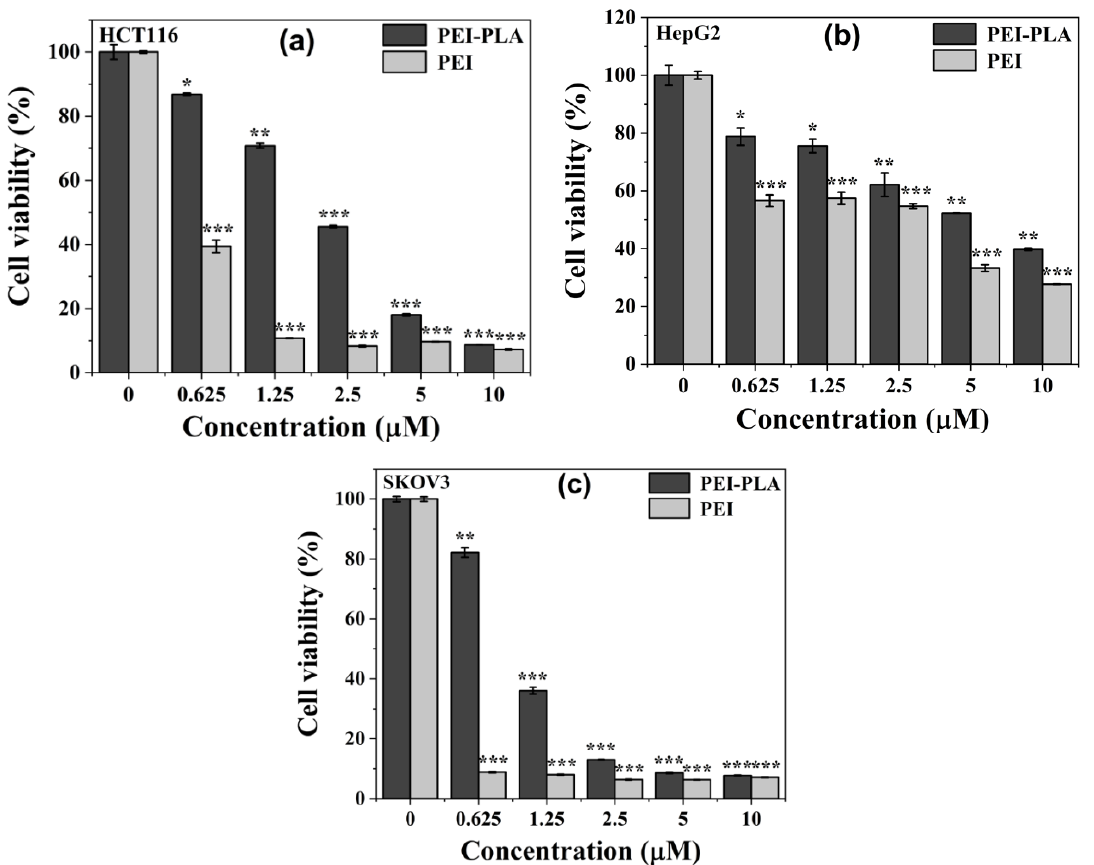
P < 0.05, ** indicates P < 0.01, and *** indicates P < 0.001, relative to the control